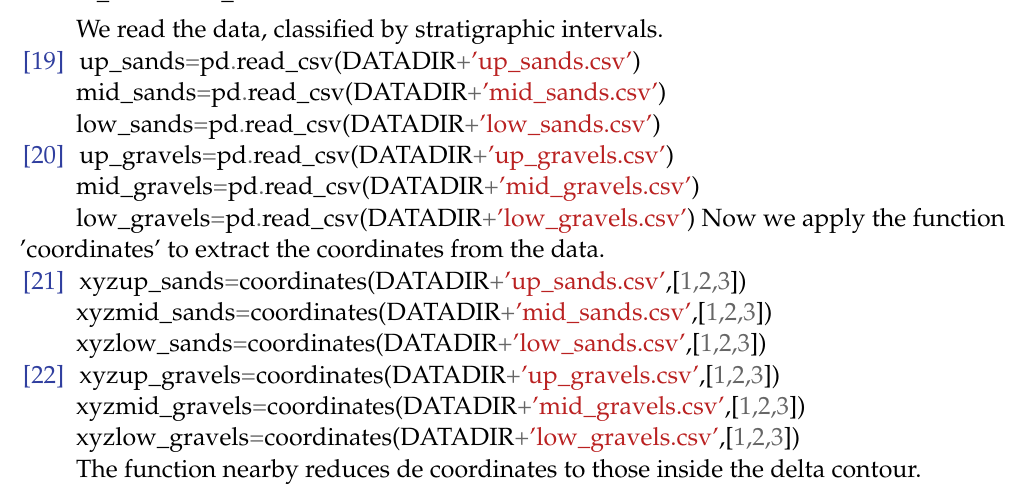
fig.add_trace(go.Scatter3d(x=xyzcontourn [0],y=xyzcontourn [1],z=xyzcontourn [2],